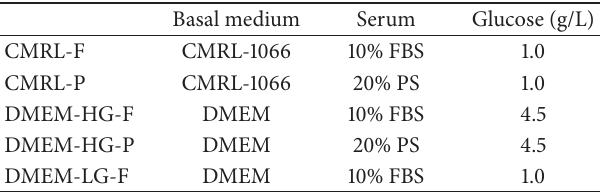
Table 1: The information of media used for cell